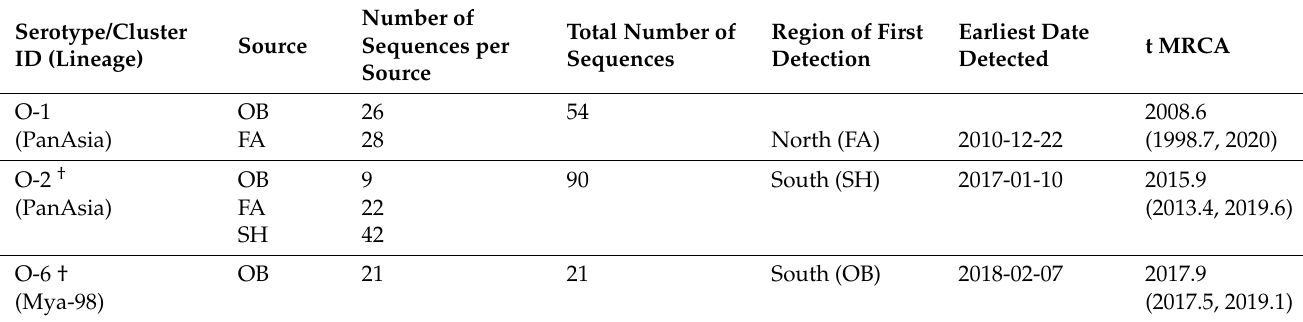
Figure 5. Spatial distribution of sequences in serotype O cluster O-2. Outbreak samples are shown in red, slaughterhouse samples in green, and farms samples in orange. Shape indicates year of sampling. Table 3. Summary of clusters with >10 sequences for both serotypes O and A. Sequences were obtained from outbreaks (OB), farms (FA), and slaughterhouses (SH). Regions of the country are divided as northern, central and southern Vietnam. † Clusters that were circulating in southern Vietnam during period of slaughterhouse